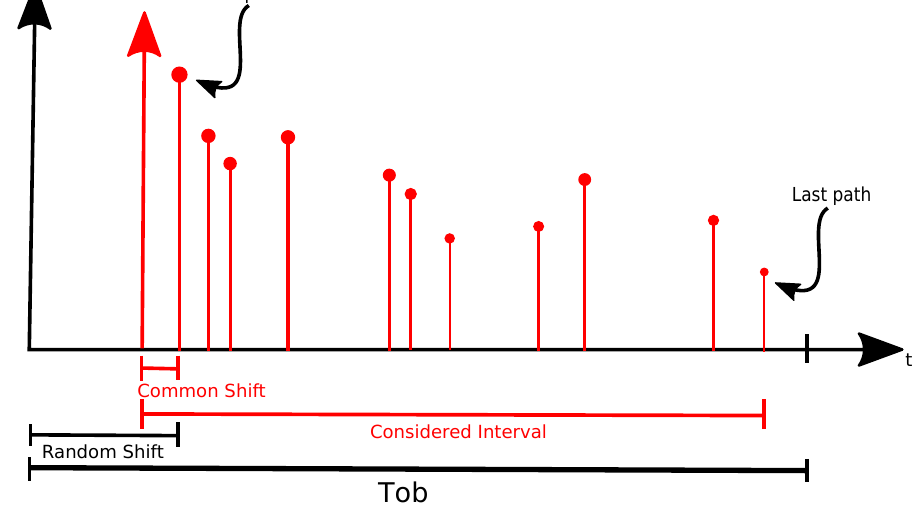
Figure 1. Example of time alignment for a generic channel impulse response